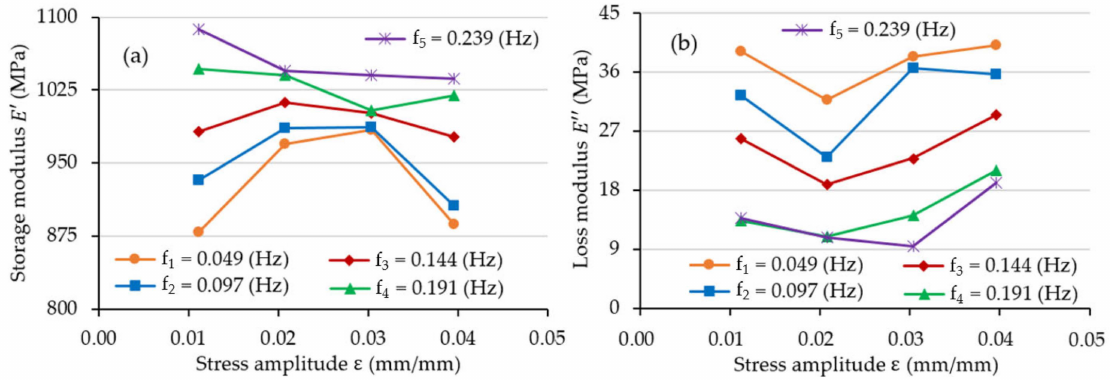
Figure 10. The value of ( a ) storage modulus E (cid:48) and ( b ) loss modulus E (cid:48)(cid:48) as a function of strain amplitude ε